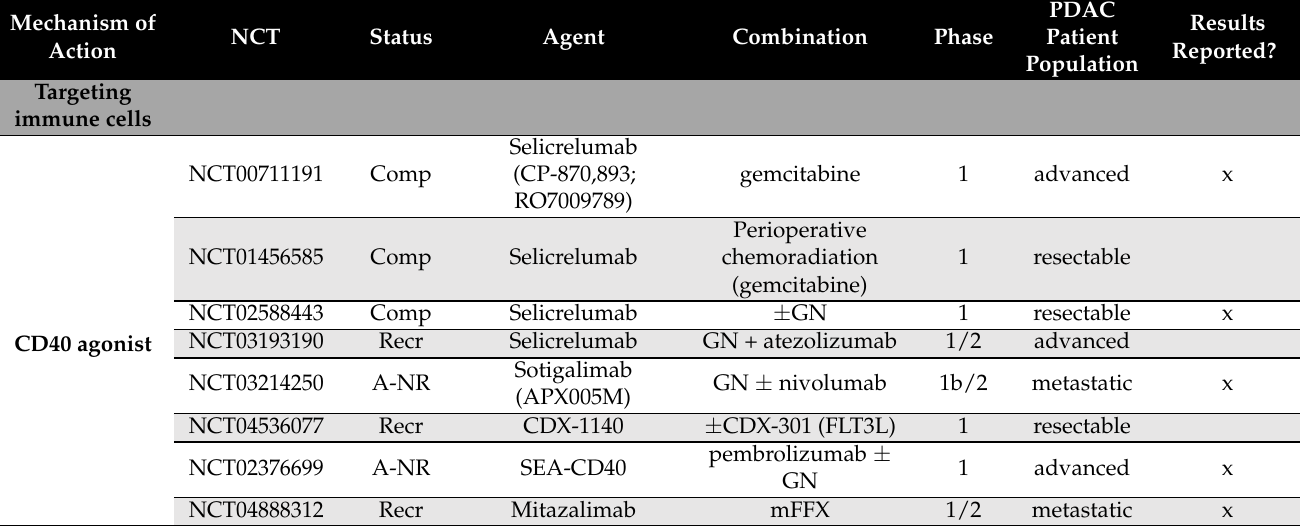
Table 1. List of active clinical trials in PDAC targeting immune cell